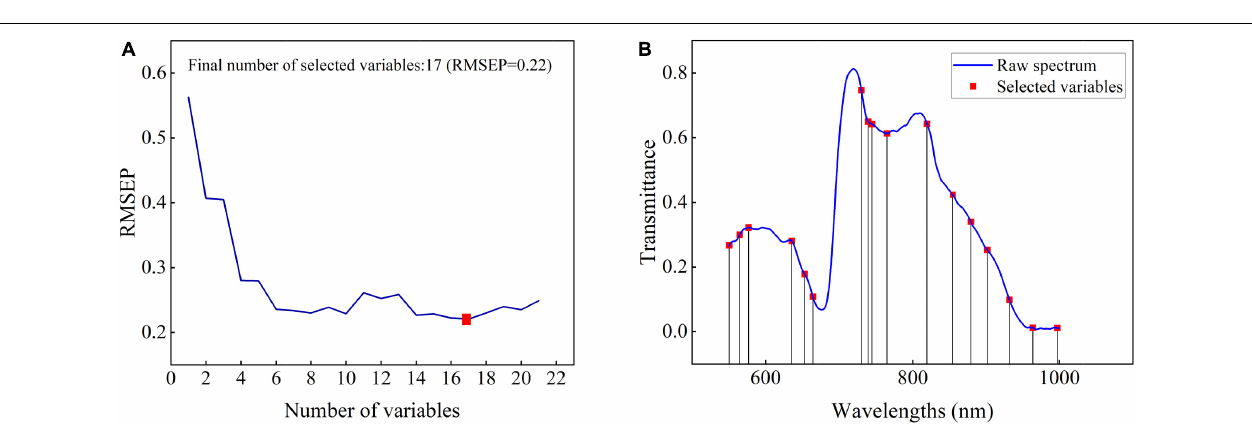
FIGURE 3 | The change of RMSEP with the selected variables by SPA (A) and distribution of 17 variables (B)